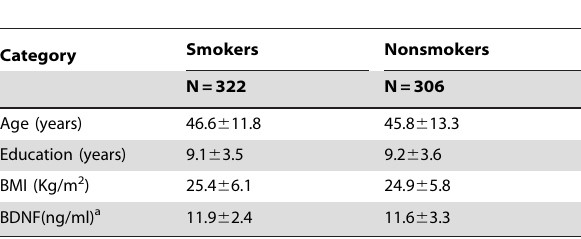
Table 1. Characteristics of smokers and